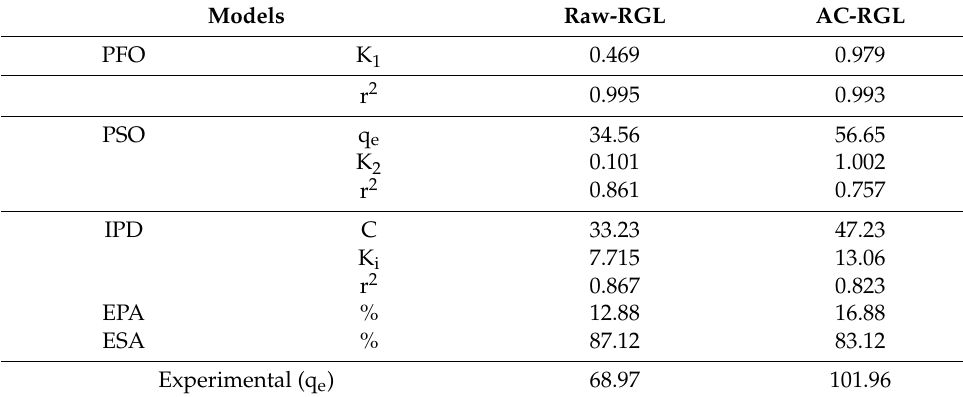
Table 5. Kinetic studies of Raw-RGL and AC-RGL and their parameters.